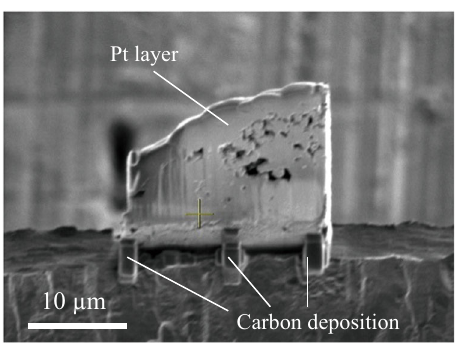
Fig. 8 Cross-sectional secondary electron image of the zircon immersed in 0.1 M NaOH (aq). The scale bar is 10 μ